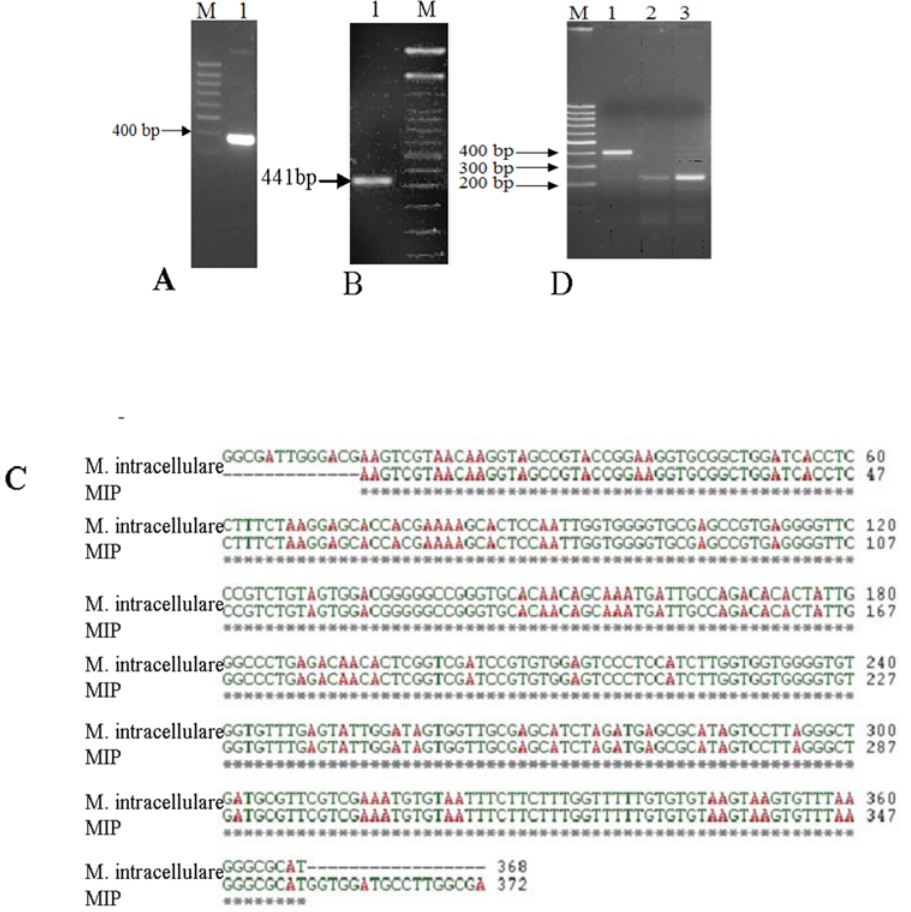
Figure 1. Confirmation of the genetic signatures of MIP(A) PCR with ITS region sequences showing a , 350 bp amplicon, M-100 bp marker (B) MIPstrain confirmation PCR with hsp65gene region, M-100 bp marker. This 441 bp amplicon was having all the 4 unique substitutions known for MIP (C) Sequence alignment of ITS sequence of MIP with MAIC organism (D) IS900 PCR to rule out MAPC lineage-M: marker, Lane 1: M. paratuberculosis control PCR, lanes 2 and 3: